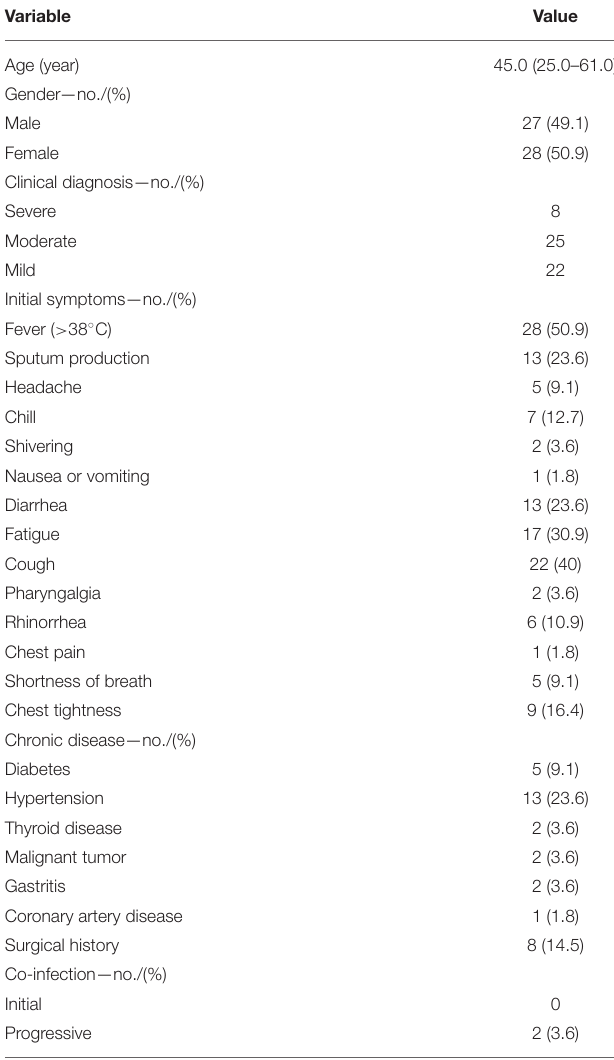
TABLE 1 | Demographic and clinical characteristics of 55 COVID-19